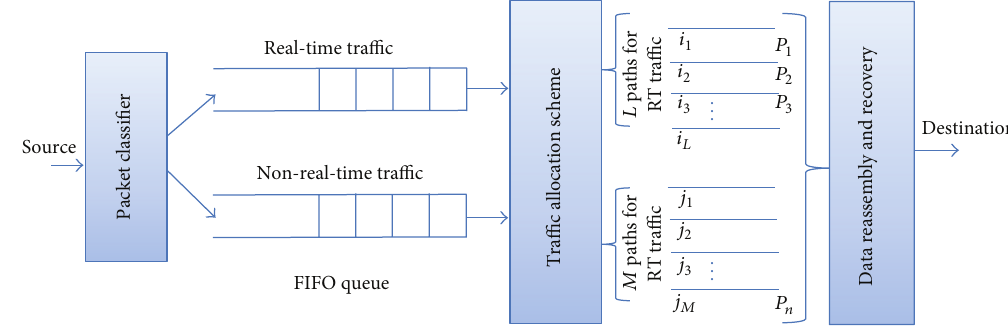
Figure 4: Functional diagram of